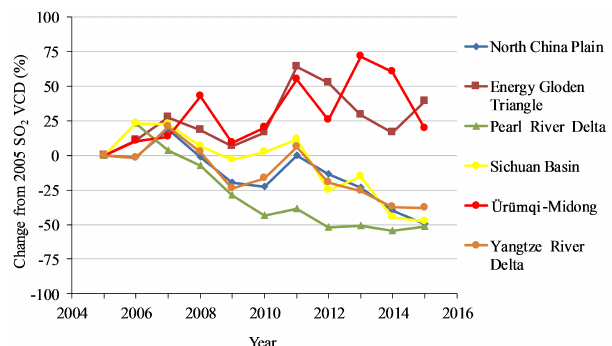
Figure 5. Percentage changes in annual mean OMI SO 2 VCD rel- ative to 2005 in four highlighted regions in eastern and southern China and two large-scale energy industry bases in the EGT and Ürümqi–Midong region in Fig.